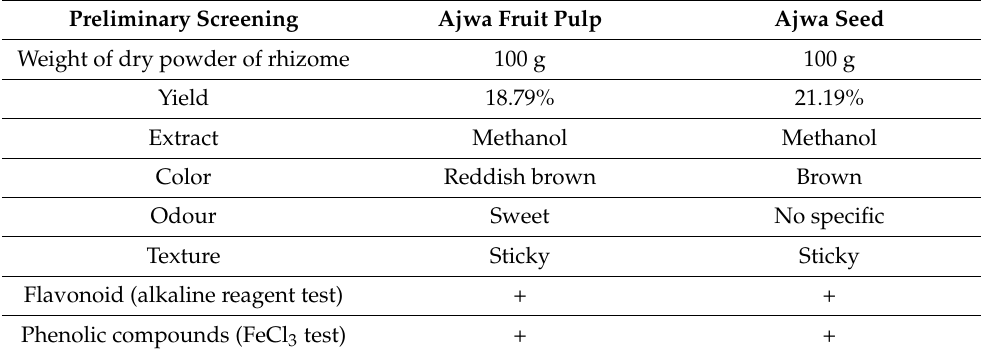
Table 1. Preliminary screening of Ajwa fruit pulp and seed extract. Preliminary Screening